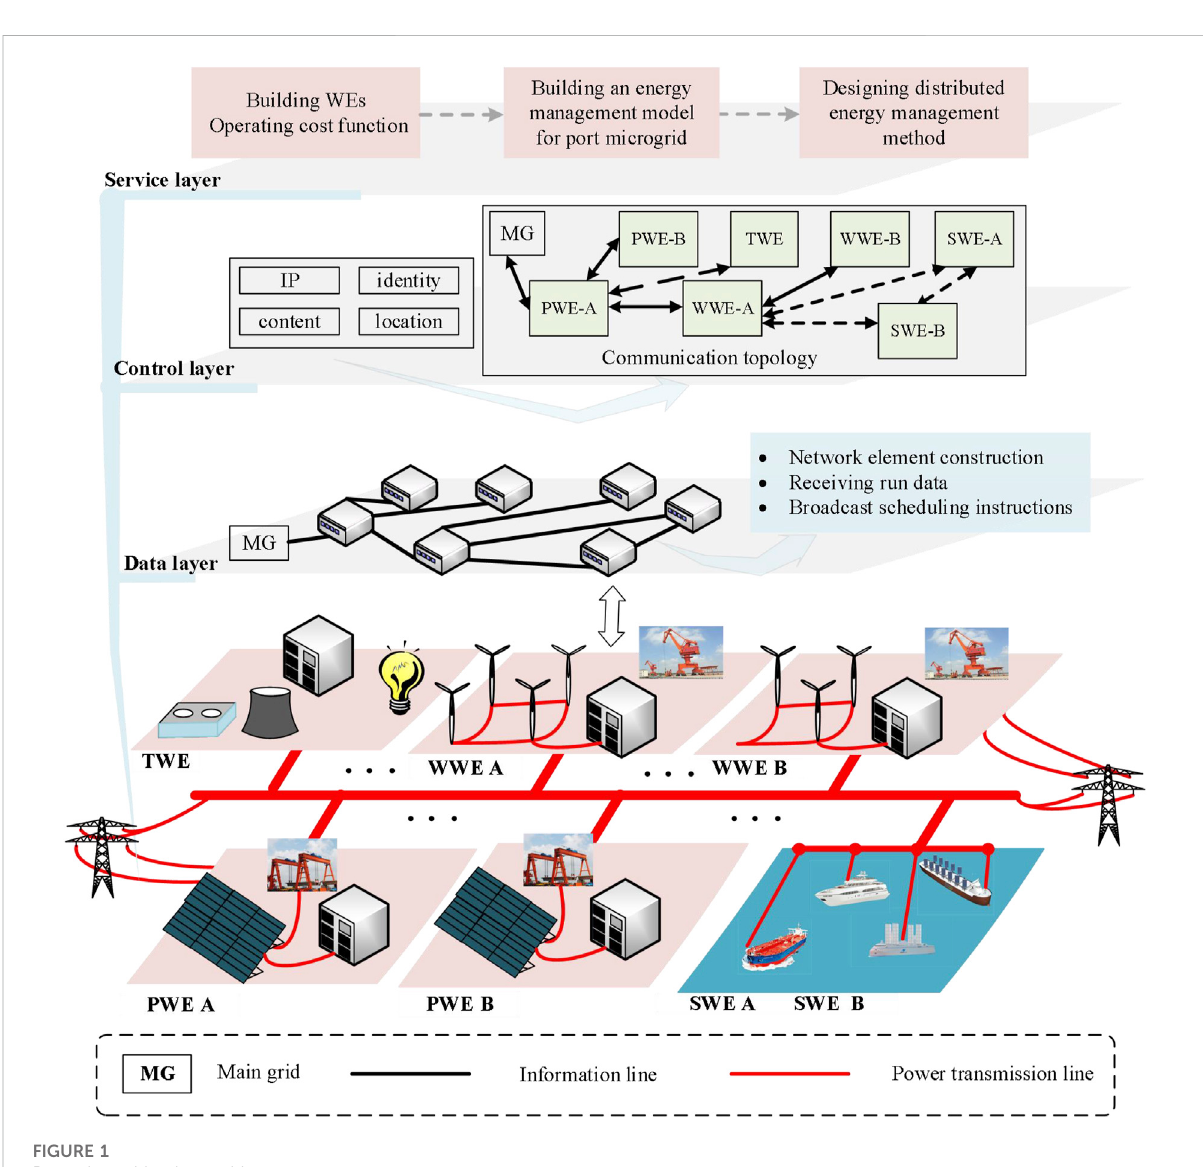
FIGURE 1 Port microgrid polymorphic energy management